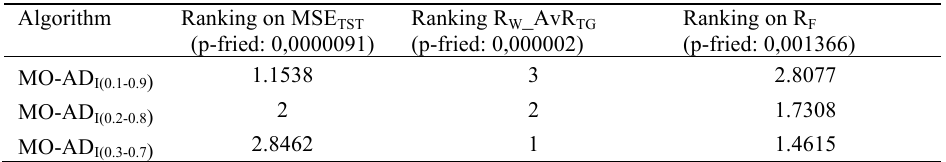
Table A.2 Rankings obtained through Friedman’s test for different values of thresholds on MSE TST , R W _AvR TG and #R F measures using FS_MOGUL rule bases for MAX ACC point.